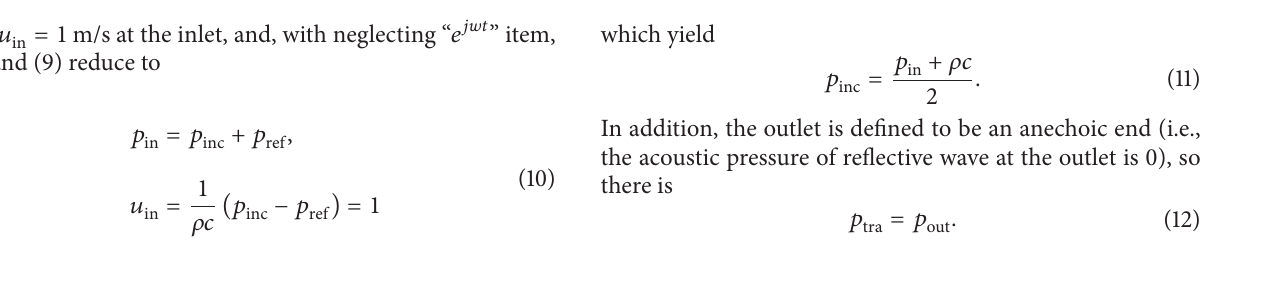
= 1 m/s at the inlet, and, with neglecting “ 𝑒 𝑗𝑤𝑡 ” and 𝑢 in